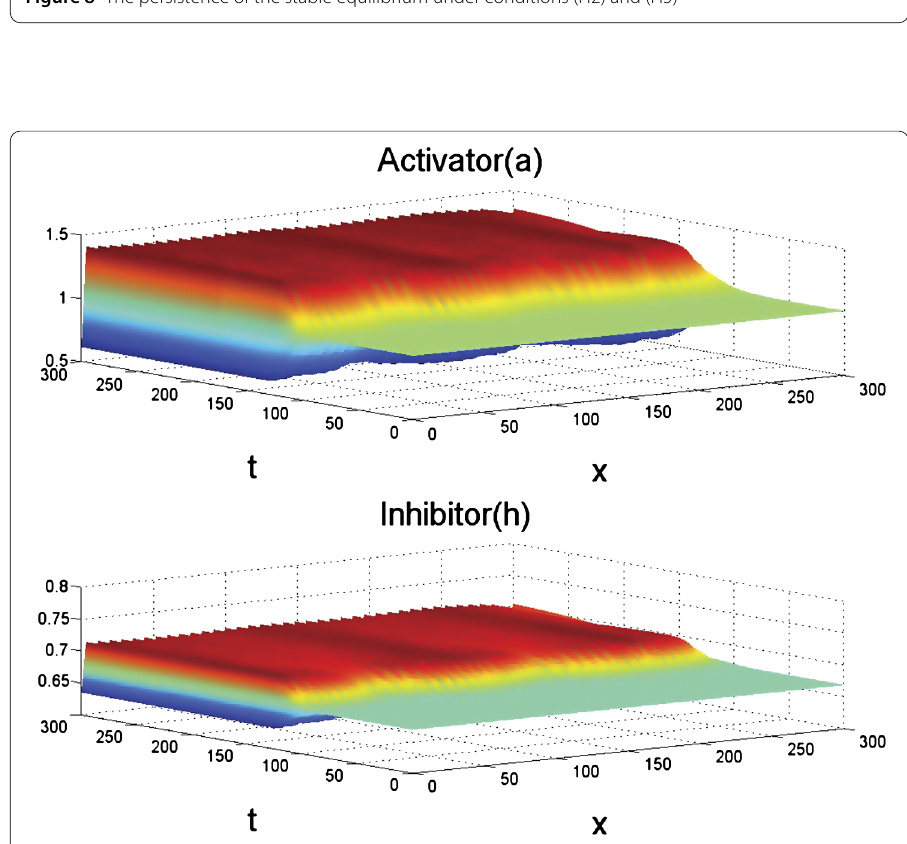
Figure 9 Turing instability of the equilibrium ( a ∗ , h ∗ ) = (1.0013,0.6684) of